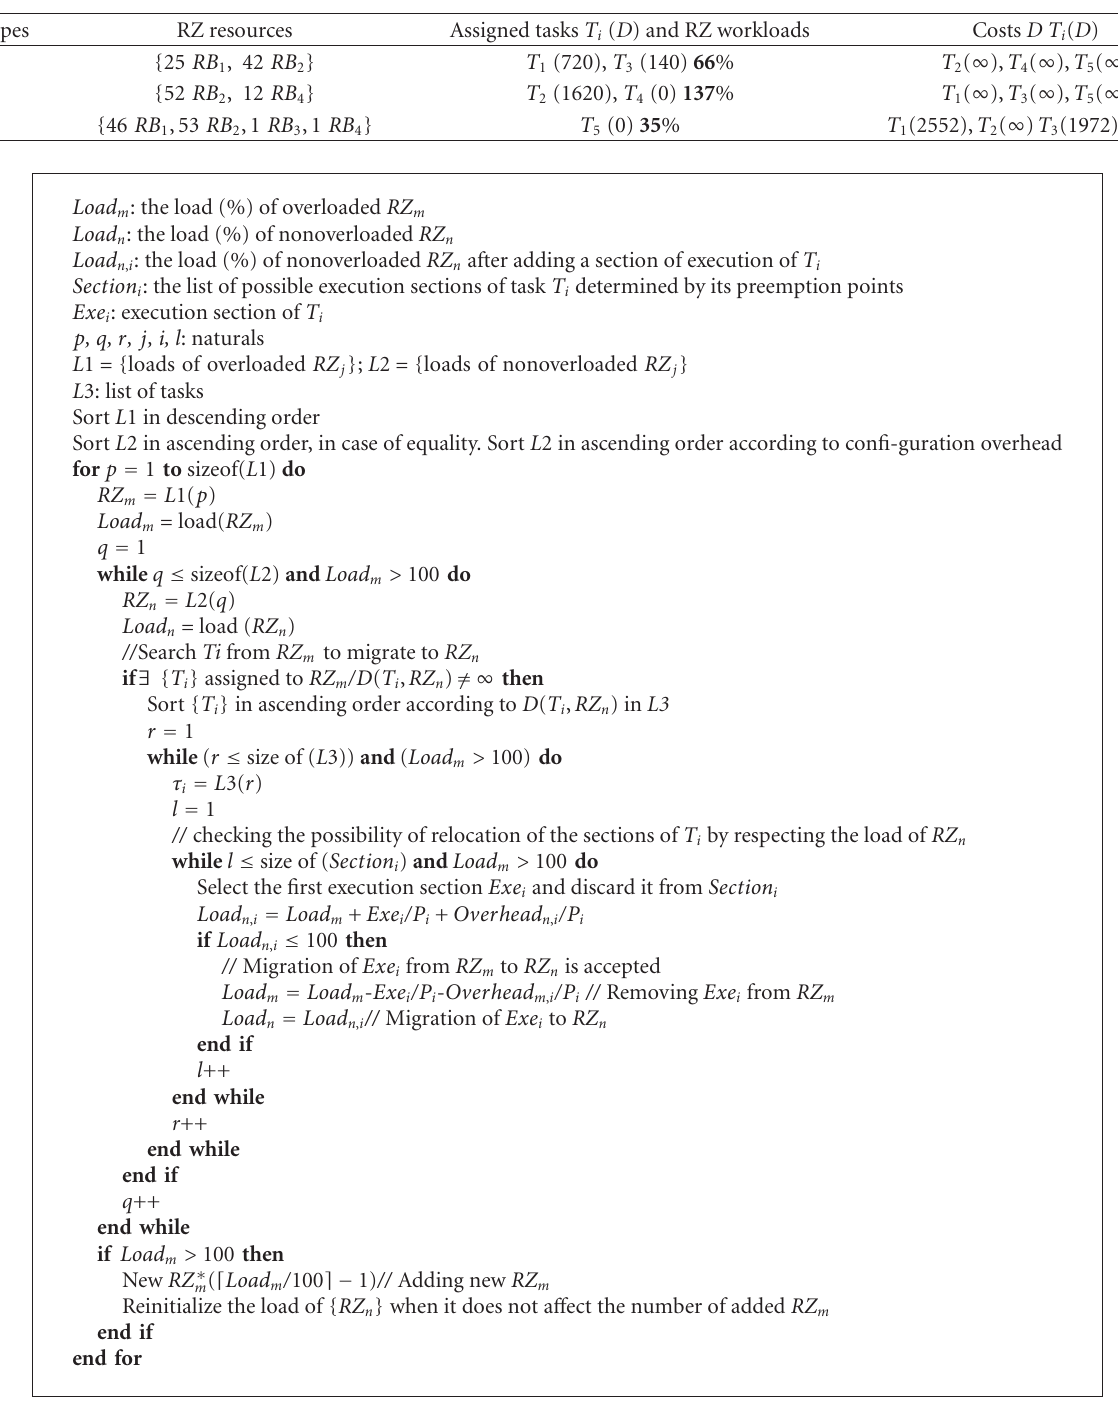
Algorithm 2: Decision of increasing the number of